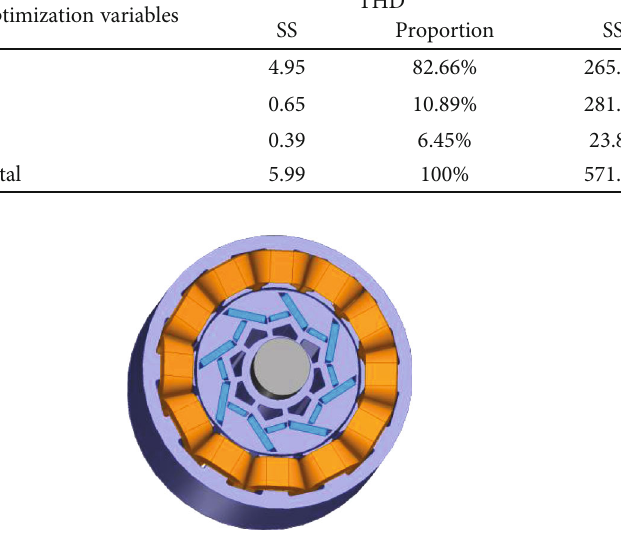
Figure 6: Motor structure after optimization.